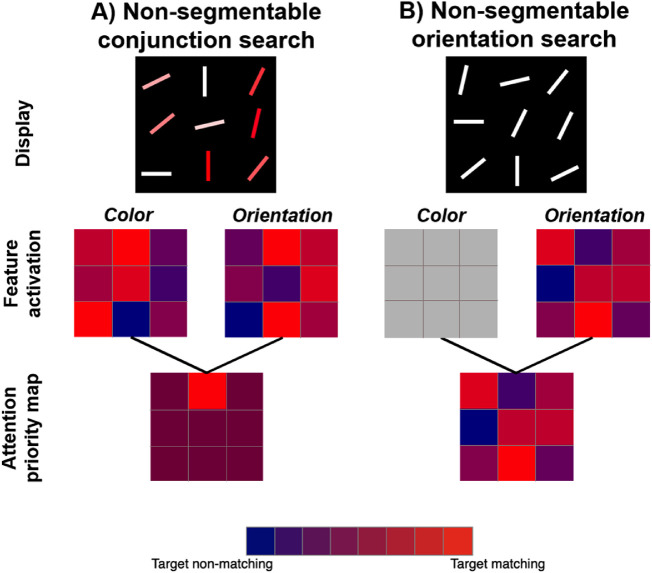
A Guided search (Wolfe, 1994; Wolfe et al., 1989) account of the results of Experiment 4. The proposed mechanism is based on the simultaneous use of top-down activation patterns from color (“redness”) and orientation (“steepness”) feature map. The color scheme for the Feature activation maps and Attention priority map is the same as in Figure 6. In (A), a combination of non-segmentable colors and orientations both provide fuzzy patterns of top-down activation, but their overlap produces an attentional priority map with many moderately activated locations and one highly activated location corresponding to a target. As a result, the search is quite efficient. In (B), non-segmentable orientations provide a fuzzy pattern of top-down activation, whereas color distribution with only one value provides no relevant information (thus shown in gray); therefore their overlap looks as fuzzy as the orientation map alone. As a result, the search becomes less efficient.